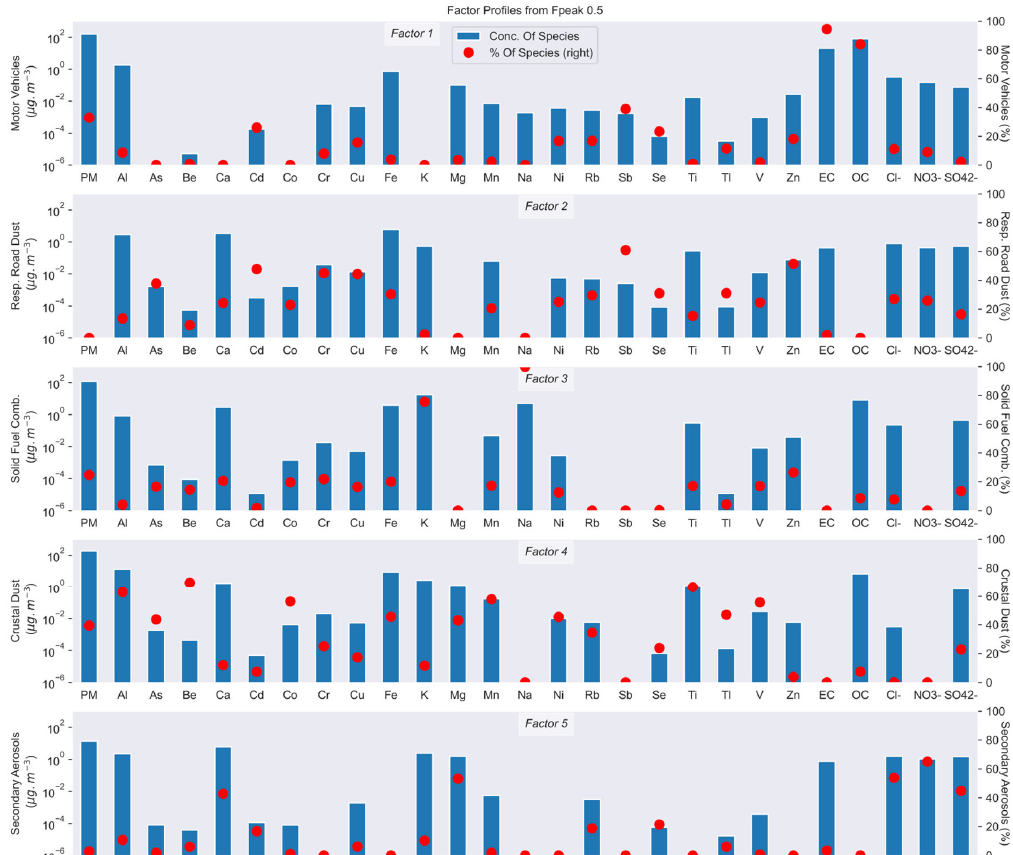
Figure 6. Pro fi les of the fi ve factors identi fi ed by the PMF in Bamako. Figure 6. Profiles of the five factors identified by the PMF in Bamako. Crustal dust : This factor is characterized by high contributions of Ti (67%), Be (70%), Mn (58%), Co (56%), V (56 %), Al (63%), and Fe (46%) (Figure 6), with the majority of them exhibiting high loadings in the PCA results (Table 2, PC1). Metals were the second most abundant component in Bamako. Al was the most abundant metal found in all particle modes (Table 1), with average daily concentrations of 17.9 µ g.m − 3 in PM 2.5 , 22.2 µ g.m − 3 in PM 10 , and 21.2 µ g.m − 3 in TSP, followed by Fe, which had values of 14.3 µ g.m − 3 in PM 2.5 , 20.4 µ g.m − 3 in PM 10 , and 21.9 µ g.m − 3 in TSP. During the dust episode, daily Al and Fe concentrations rose by nearly a factor of 13 (from 6.3 to 82.2 µ g.m − 3 ) and 12 (from 5.3 to 66.7 µ g.m − 3 ), respectively. The peak concentrations of Al and Fe during the dust